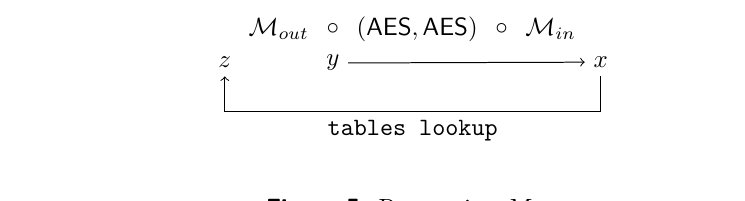
Figure 5: Recovering M